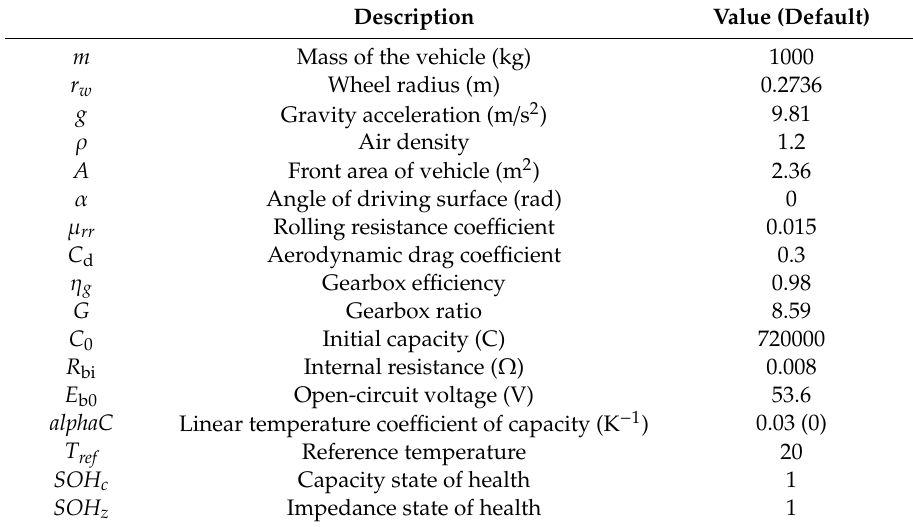
Table 1. EV simulation parameter setting values.